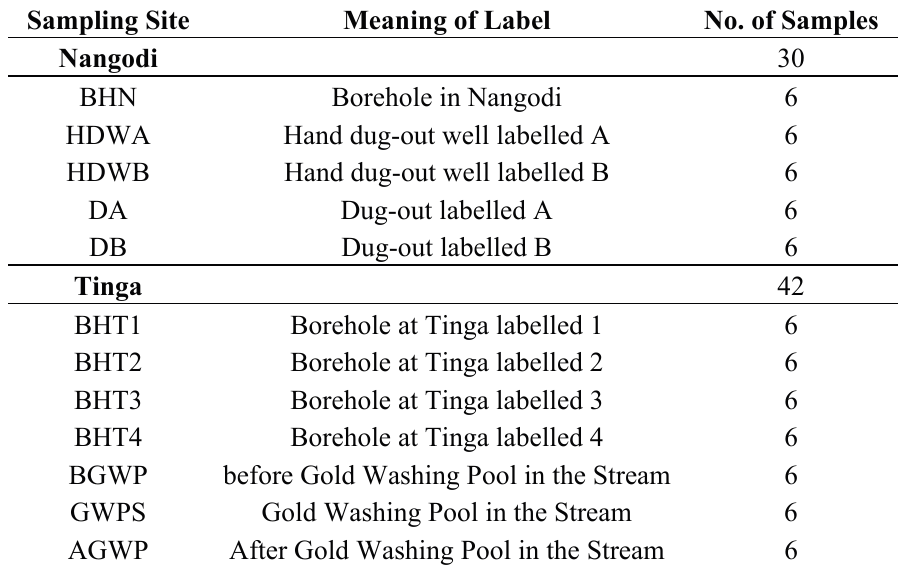
Table 1. Describing the sampling sites, sampling size and containers used for the